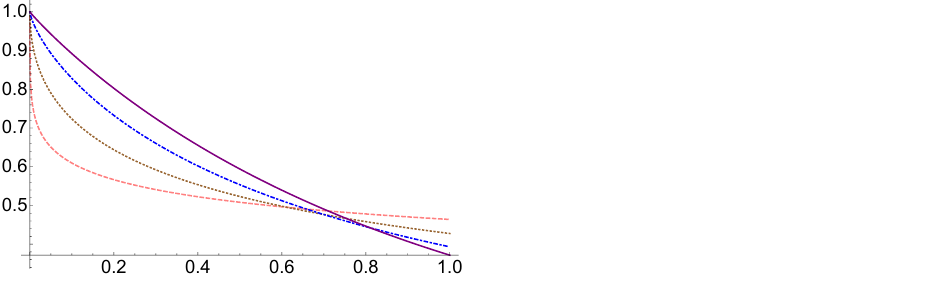
Figure 8. f ( x ) , where q = 0.25 (dashed), q = 0.5 (dotted), q = 0.75 (dashed-dotted), and q = 0.95 (continuous), with α = q , for Example